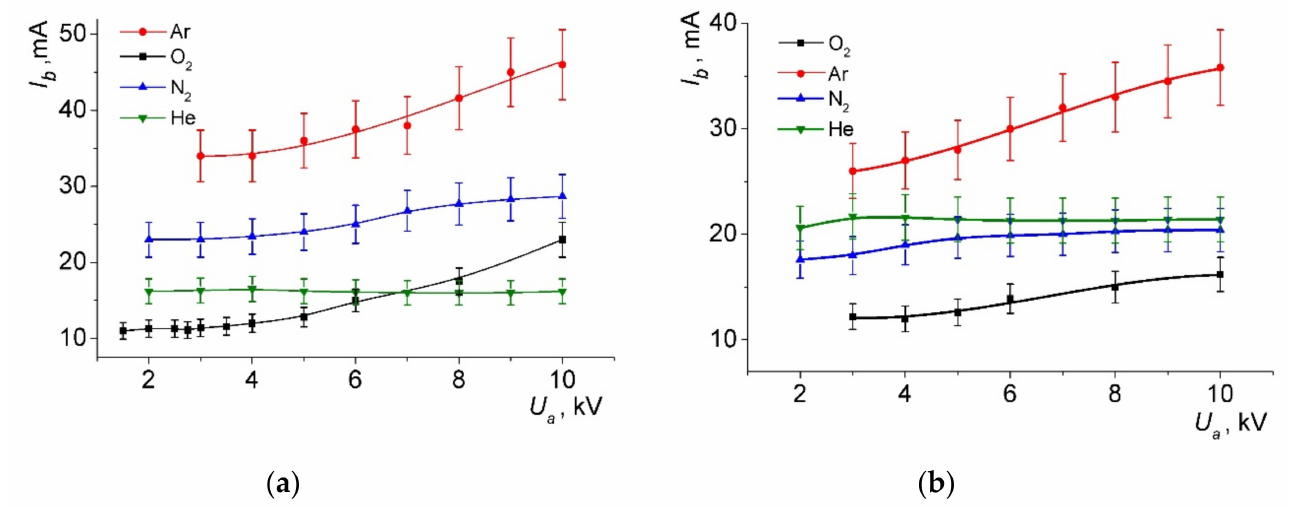
Figure 4. Beam current versus accelerating voltage for different pressures: ( a ) 4.2 Pa and ( b ) 2.6 Pa. Discharge current is 600